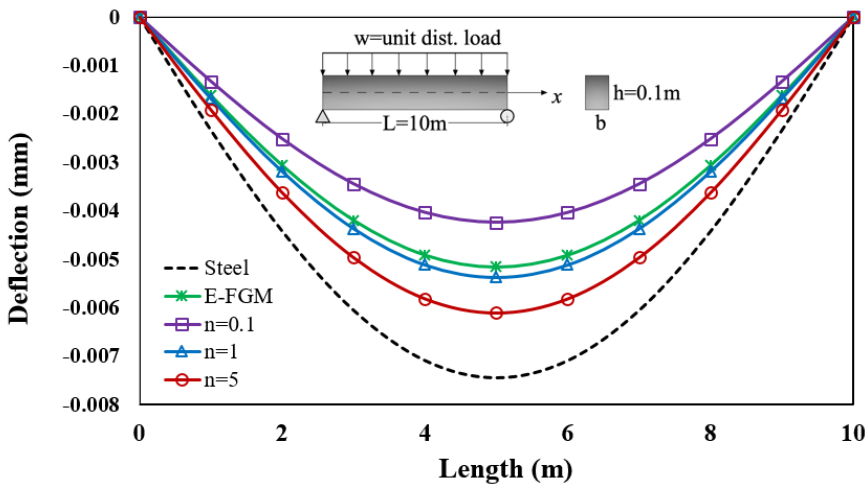
Figure 9. Deflection of a simply supported FGM beam.